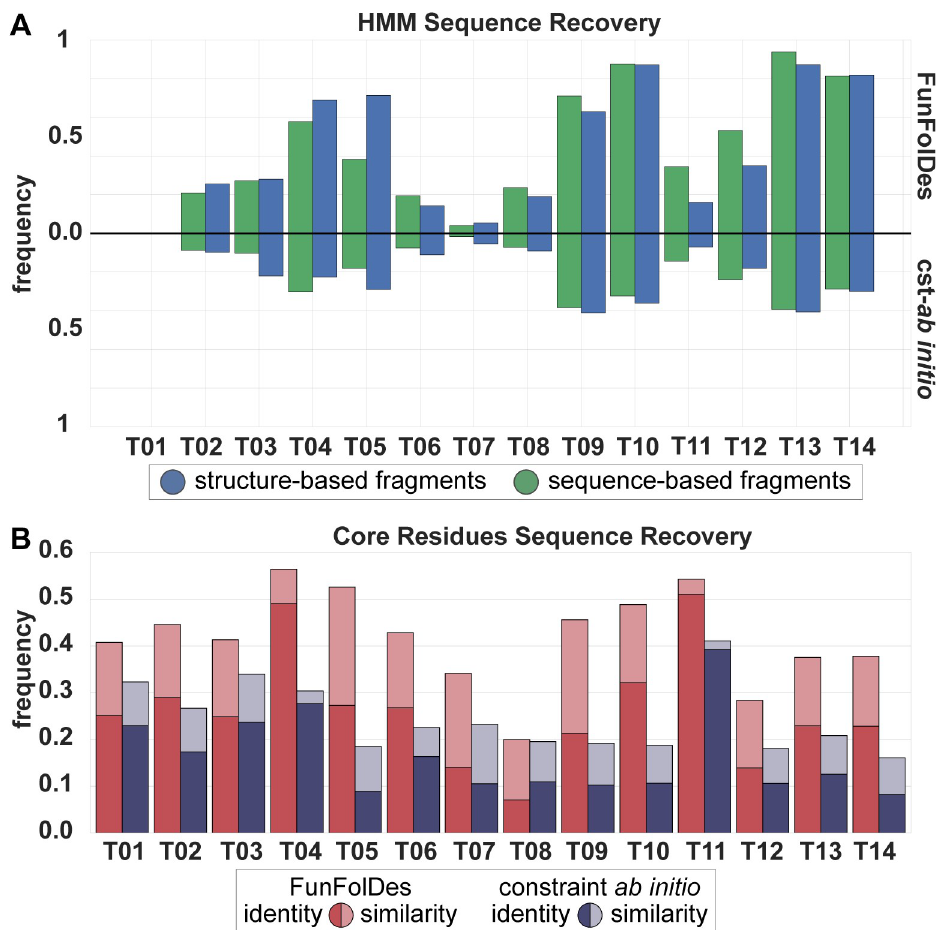
Fig 3. Assessment of FunFolDes sequence sampling quality. A) HMM Sequence Recovery measures the percentage of decoys generated that can be assigned to the original HMM from the CATH superfamily. FunFolDes consistently outperforms cst– ab initio , in agreement with the structural recovery metrics. B) Core Residues Sequence Recovery shows the sequence recovery between the core residues of the designs set and the target. Recovery is measured in terms of sequence identity and sequence similarity (as assigned through BLOSUM62). Core sequence identity and similarity was assessed over the structure-based fragment set. According to this metric FunFolDes outperforms cst- ab initio in every instance, reaching for some populations, levels of conservation similar to those found in more restrained flexible- backbone design approaches